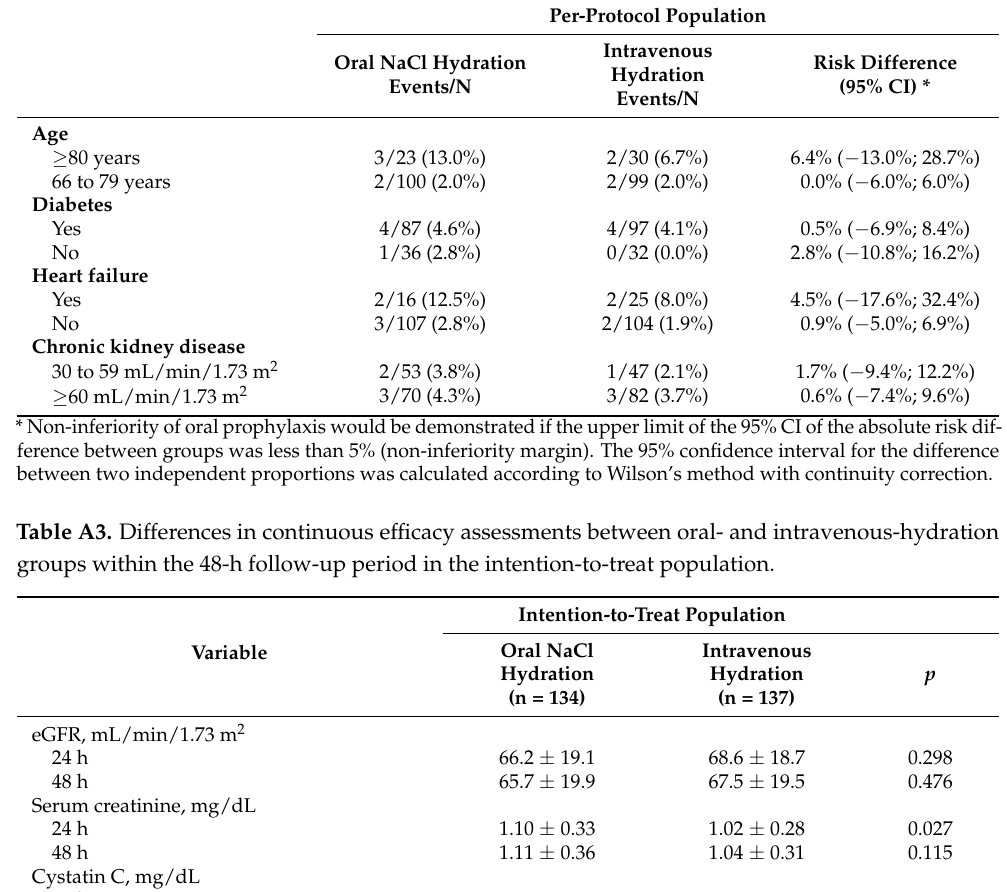
Table A2. Subgroup analysis (per-protocol population).